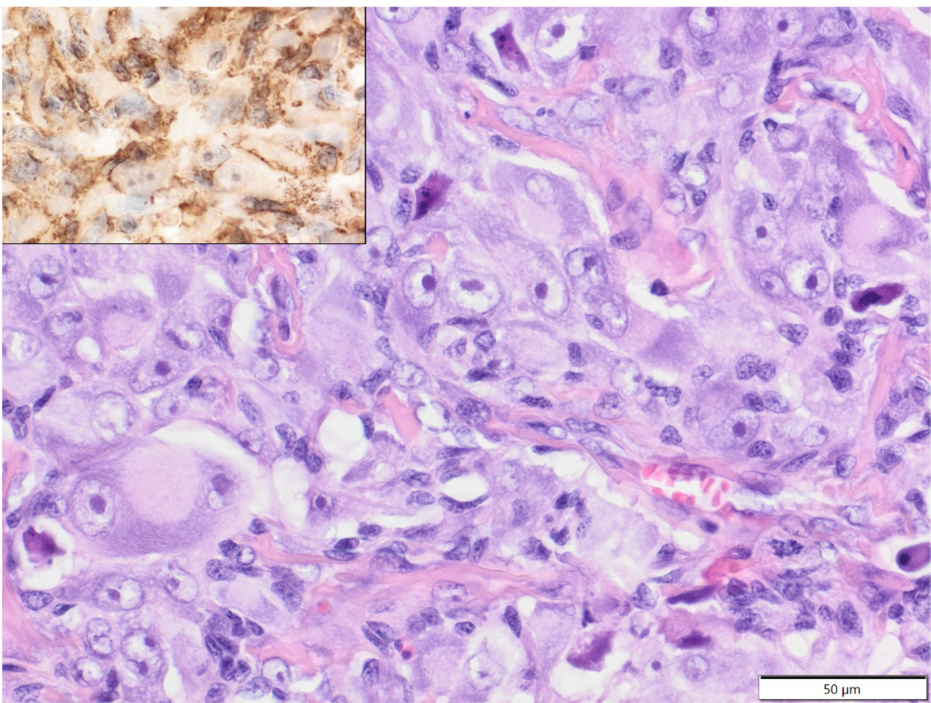
Figure 6. Histiocytic sarcoma, forelimb, African pygmy hedgehog. Pleomorphic tumour cells show high anisocytosis and anisokaryosis. Nuclei are large with marginated chromatin and distinct, single nucleoli. HE. Inset: tumour cells show expression of Iba-1. IHC.